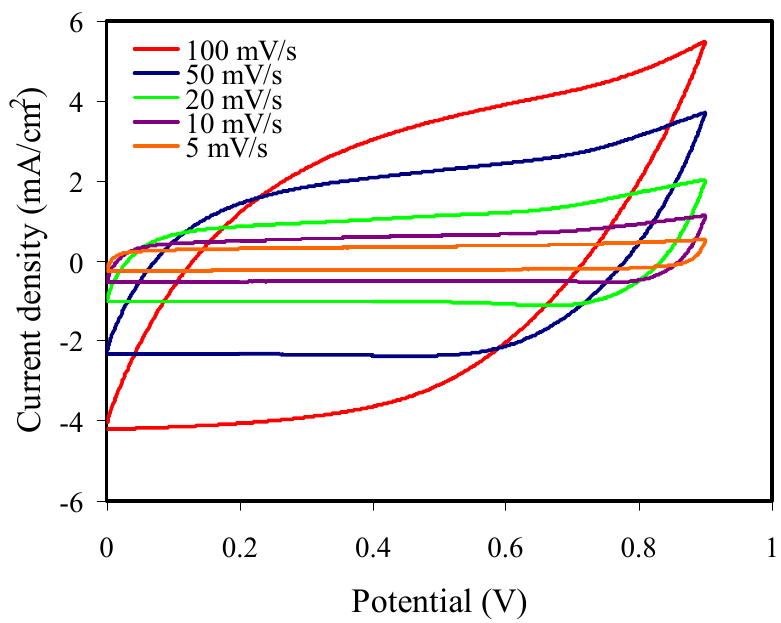
Figure 10. Cyclic voltammetry (CV) curve for the highest plasticized sample (PSP_2) at RT. Table 5. Capacitance from CV curves.